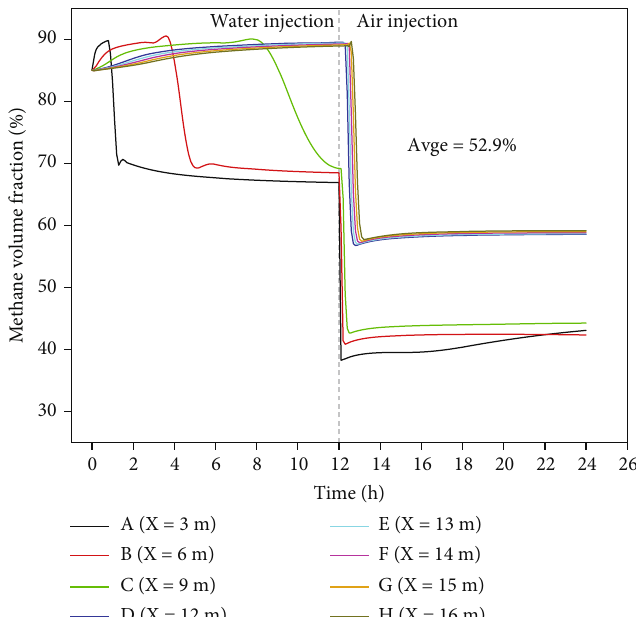
Figure 11: Time-dependent V